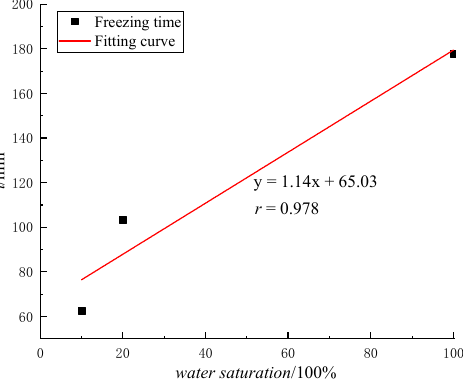
Figure 8. Relationship between different water saturation and freezing time.